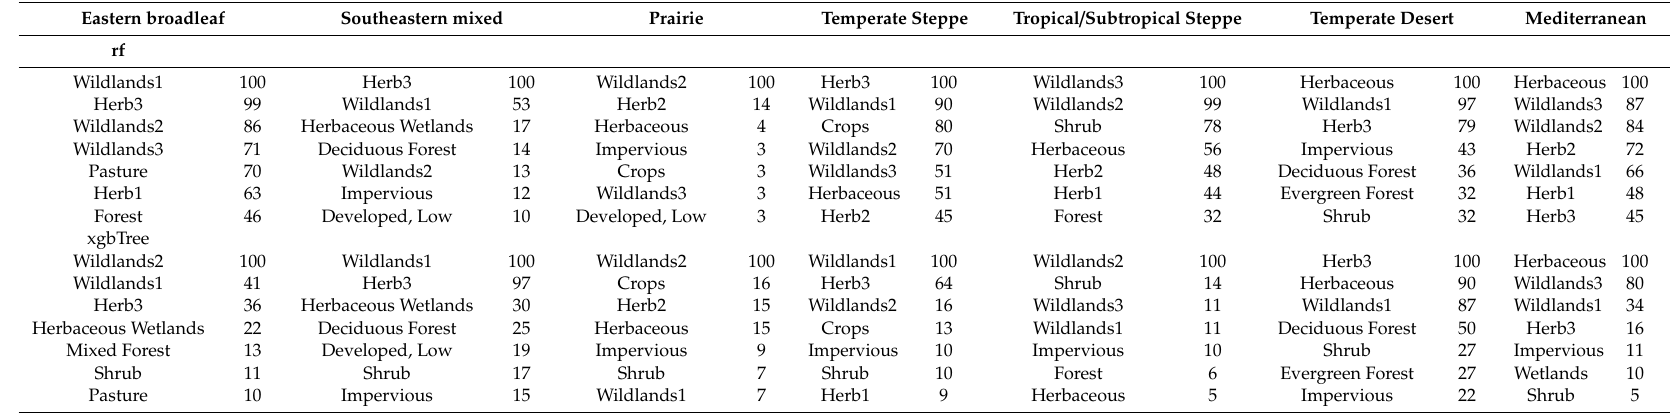
Table 7. Most important variables and value for random Forests (rf) and extreme gradient boosting (XgbTree) models by ecoregion (Wildlands1 = Forest + Grass + Shrub + Wetlands; Wildlands2 = Forest + Grass + Wetlands; Wildlands3 = Forest + Grass; Herb3 = Pasture + Crops + Developed, Open; and Herb2 = Grass + Pasture). Eastern